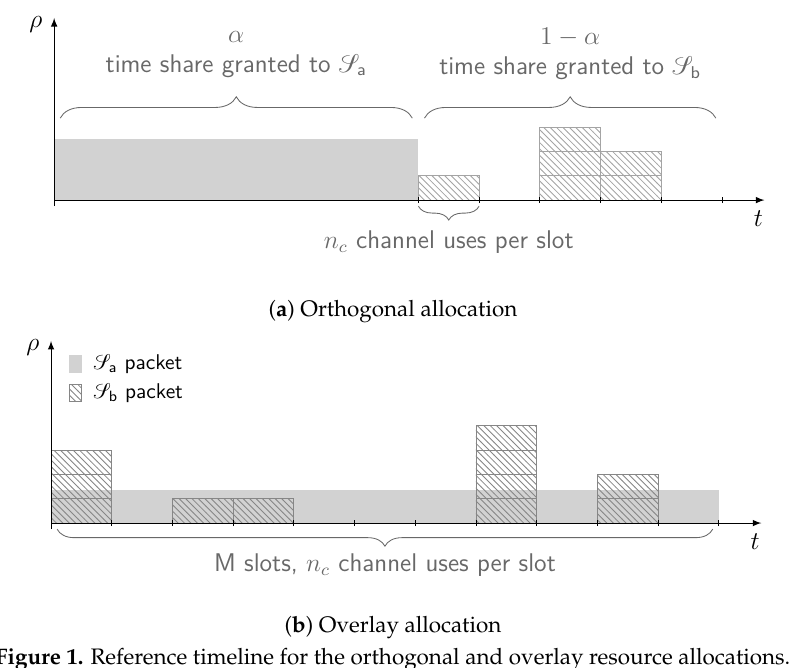
Figure 1. Reference timeline for the orthogonal and overlay resource